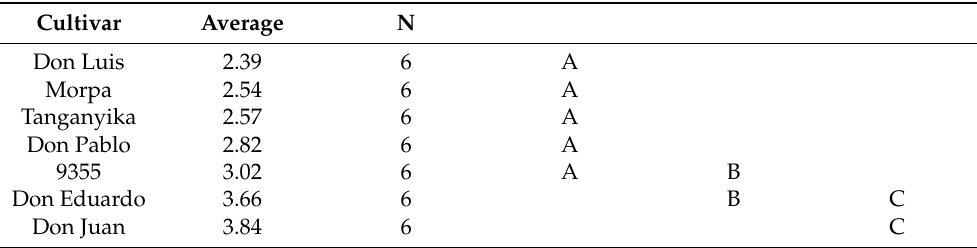
Table 2. Mean values of the phytolith content (%) in the dry matter of different weeping lovegrass cultivars at two phenological stages: outbreak and re-growth. Different letters indicate significant differences ( p < 0.05) according to the Fisher test. Error: 0.3530, df: 26. Cultivar